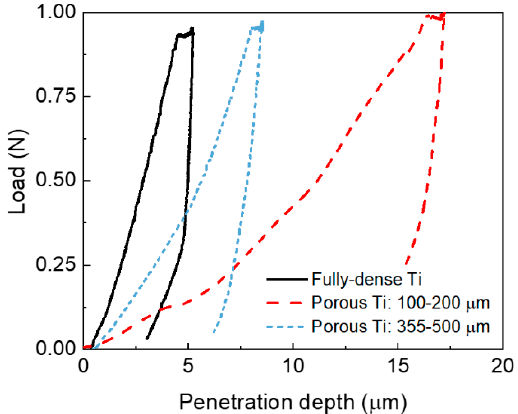
Figure 7. Pseudo-creep behavior of fully-dense (in black) and porous Ti (in red and blue, respectively) substrates.